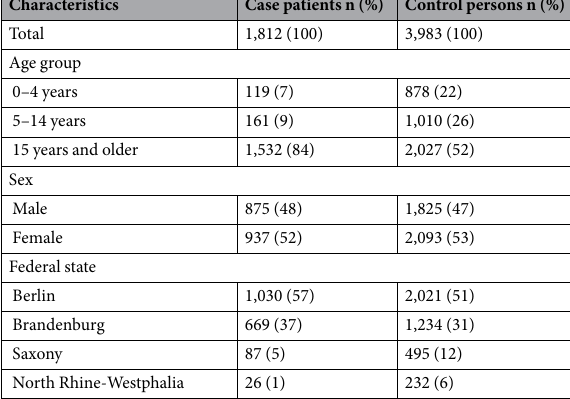
Table 2. Characteristics of the study population. Case-control study, Germany,